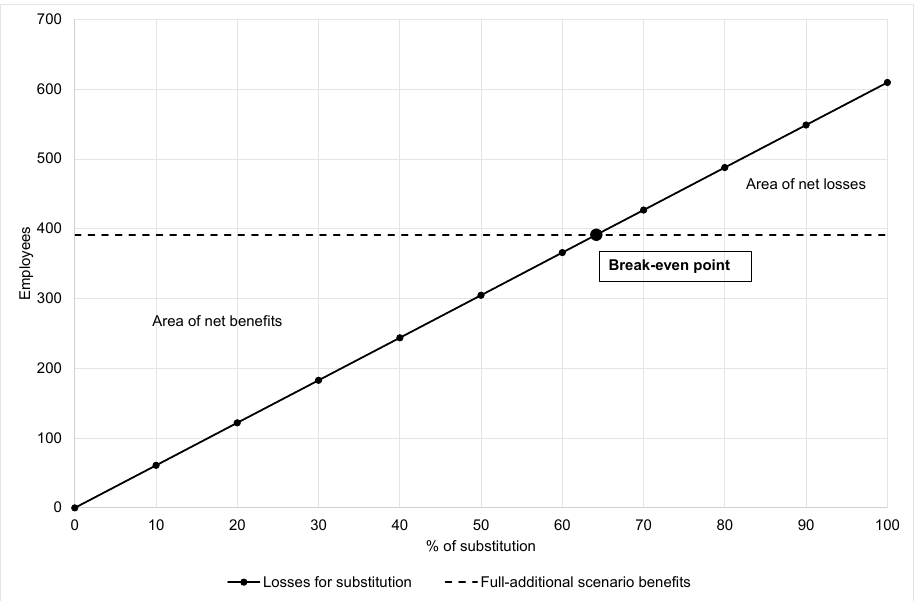
Figure 4. Benefits and losses in terms of employment generated by the cardoon supply chain in Sar- dinia,